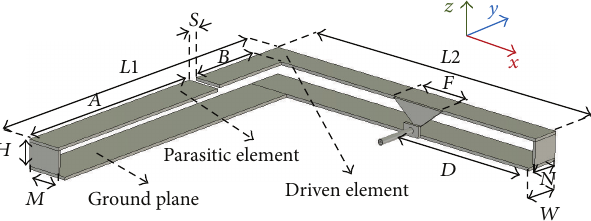
Figure 12: Geometry of the proposed dual-band L-shape PIFA.